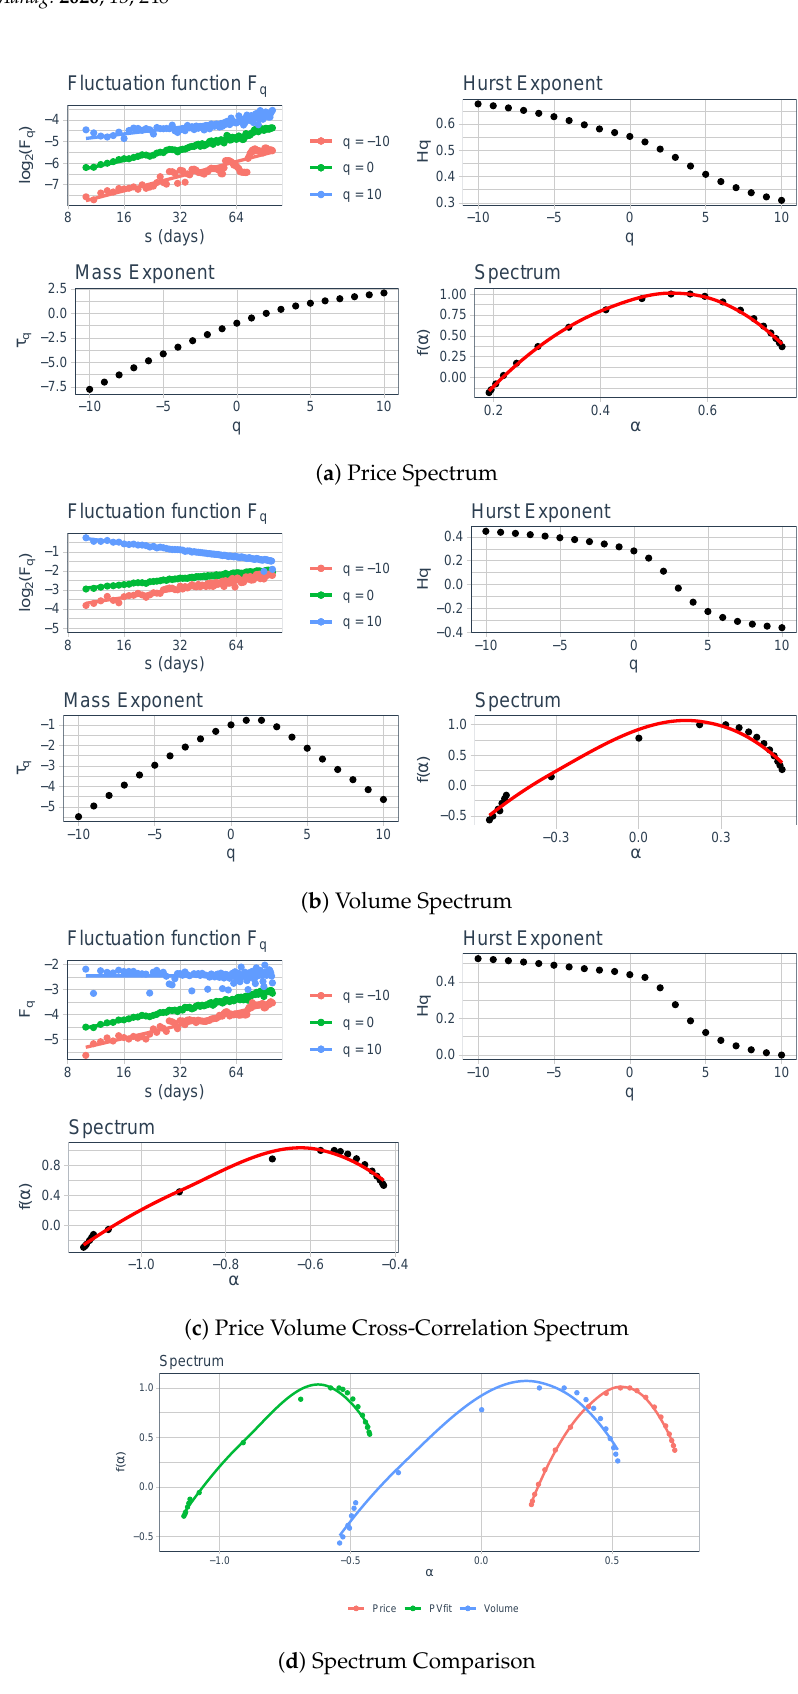
Figure 7. Segment 3 price, volume, and price-volume cross-correlation